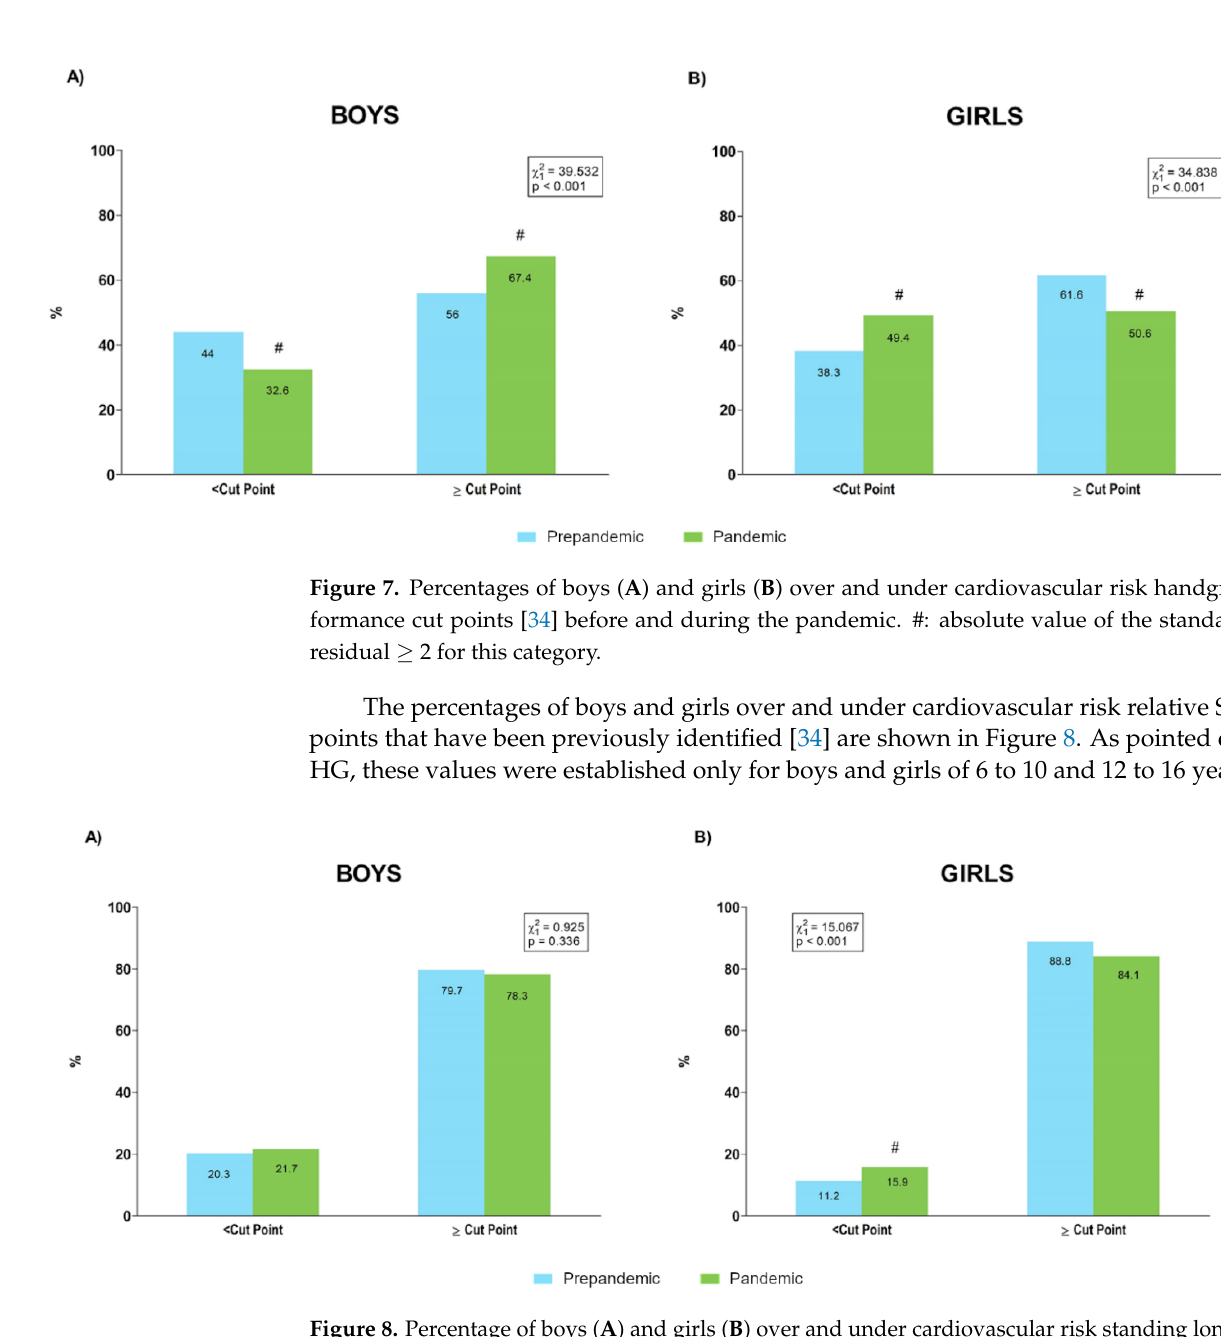
Figure 9. Percentages of boys ( A ) and girls ( B ) over and under cardiovascular risk 20 m shuttle run test performance cut points [35] before and during the pandemic. All contingency tables with the distributions of prepandemic and pandemic samples for body composition (i.e., BMI and WHtR) and physical fitness (i.e., HG, SLJ and 20 m